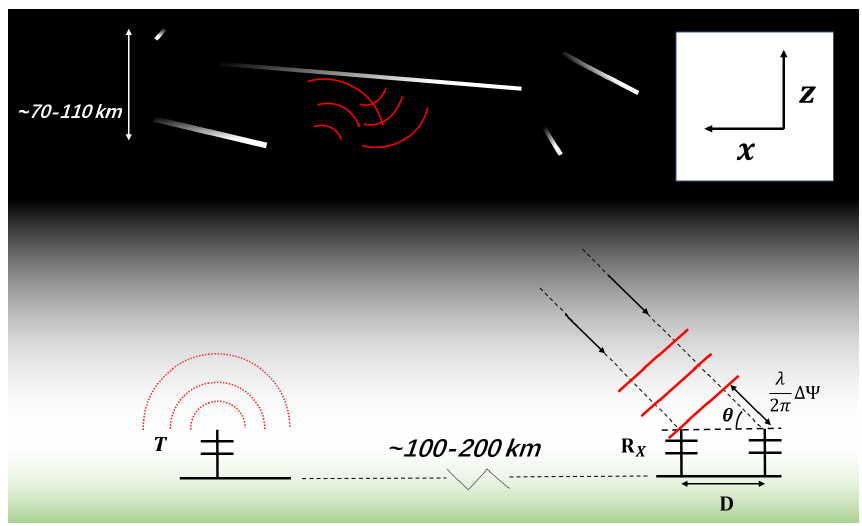
Figure 1. Schematic diagram of the simplified bistatic configuration used in Hocking’s vertical resolution analysis (Hocking, 2018). The two receiving antennas and the transmitting antenna are collinear. The analysis is in a two-dimensional vertical section through the baseline joining the antennas. The radio wave is scattered from a few Fresnel zones that are several kilometers in length around the specular point on the meteor trail and are received by the receiving antennas. The cross-correlation analysis between the receiving antennas can be used to solve for the AoAs. Because the radio wave is reflected from a region a few Fresnel zones in length, the measured phase difference between the receiver antenna pairs to deviates from the ideal phase difference. This deviation from the ideal phase difference is one of the error sources in the PDME. In this work, we solve for the ideal phase difference associated with the AoA directed to the